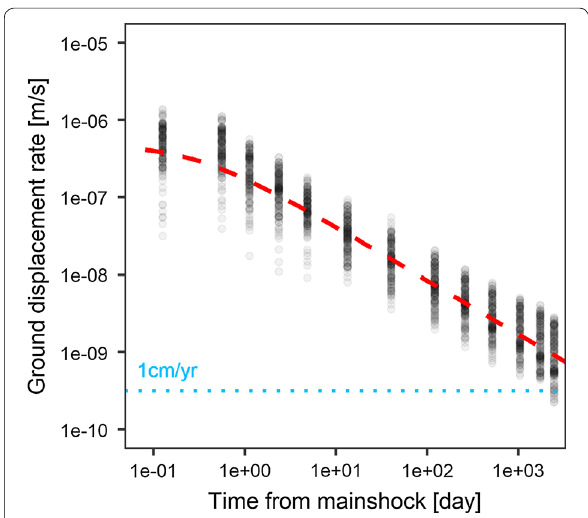
Fig. 2 Evolution of the horizontal ground displacement rates after the 2011 Tohoku Earthquake. We plot the displacement rates of the stations at the midpoints of the time frames. The red dashed line represents the best-fit to the observations based on Eq. (1) with p d = 0.69 . The blue dotted line shows a reference of the displacement rates of 1 cm/year, as a typical value of tectonic deformation Fig. 3 Seismicity after the 2011 Tohoku megathrust earthquake